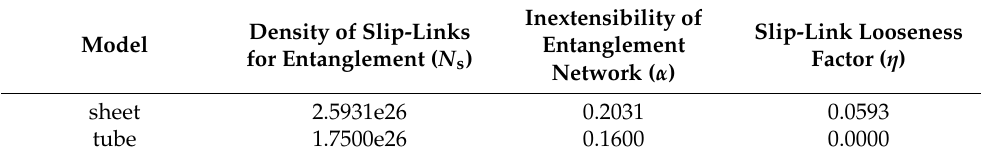
Table 2. Comparison of material parameters for PLLA sheets and